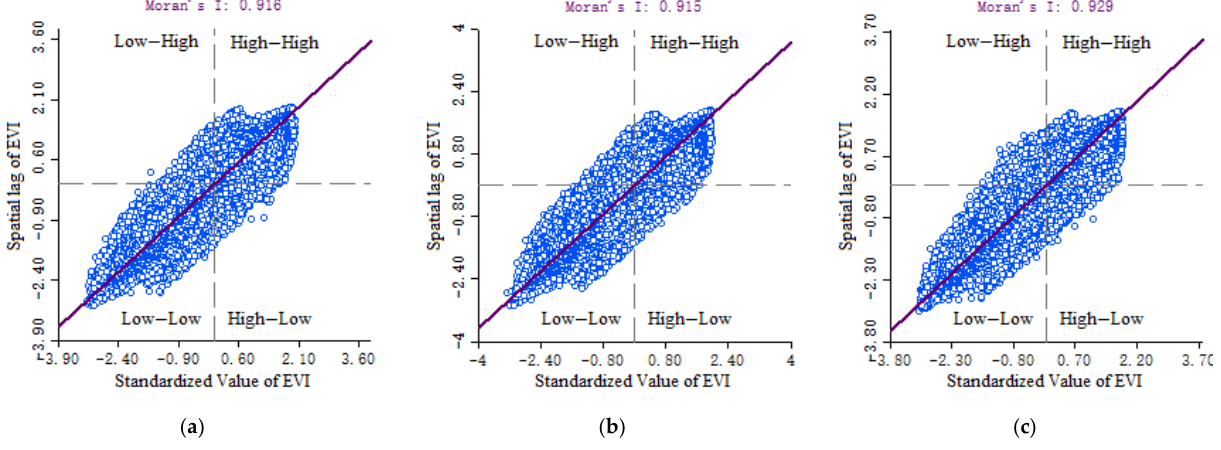
Figure 7. Moran scatterplot of EVI on the Qinghai-Tibet Plateau in ( a ) 2005, ( b ) 2010, ( c ) 2015. Using the local spatial autocorrelation index, the distribution of EVI spatial clustering characteristics and the spatial variation difference on the time scale can be seen intuitively from 2005 to 2015 (Figure 8). In 2005, 2010 and 2015, the distribution of spatial clustering characteristics was similar. The spatial clustering characteristics of EVI on the